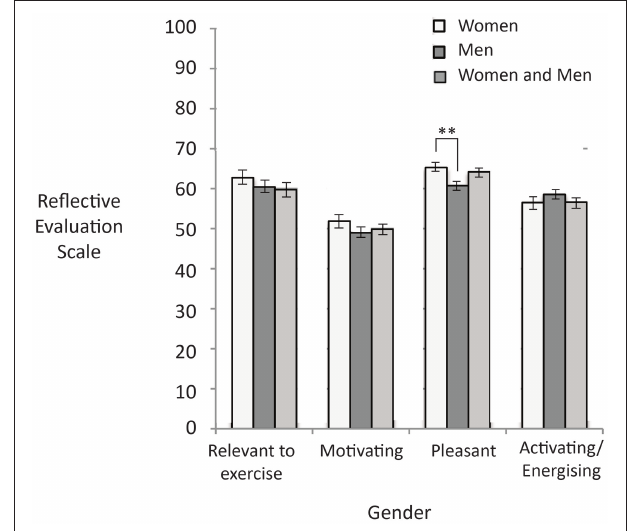
FIGURE 6 | Higher scores represent higher reflective evaluation ratings on the 0–100 response scale. Significant differences are noted with asterisks. Error bars reflect standard